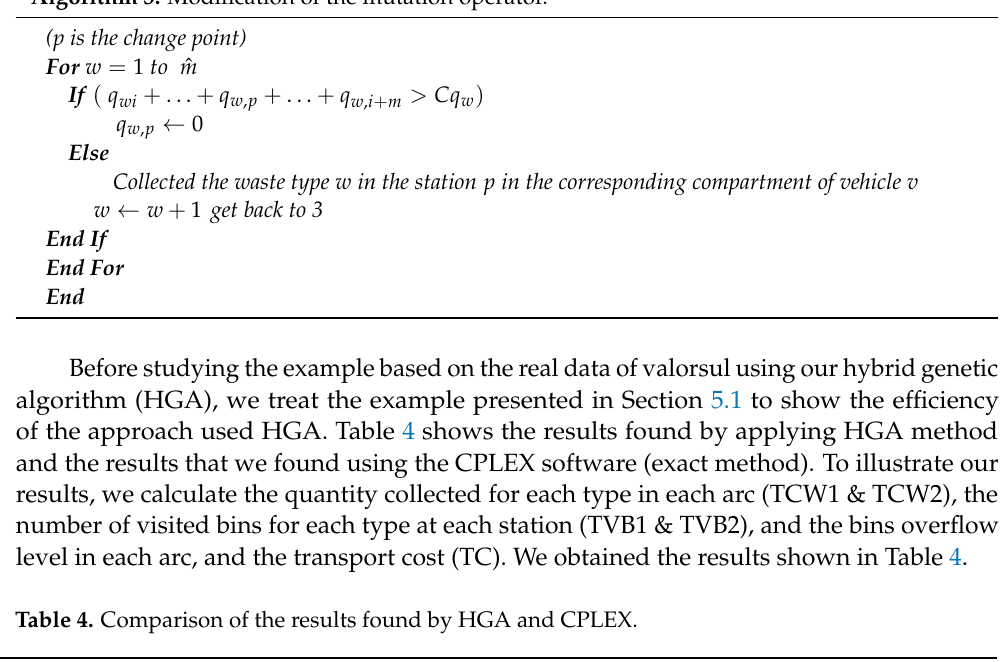
Algorithm 3: Modification of the mutation operator.